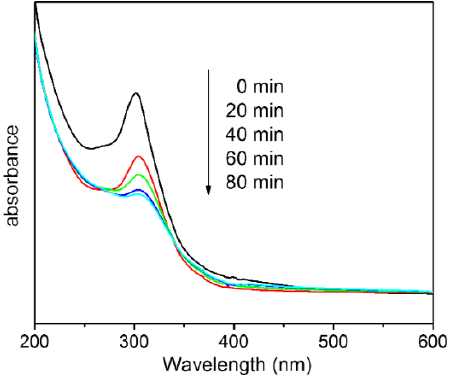
Figure 2. Time-gradient UV-vis spectra of VO 2 gel film coated on a quartz substrate.